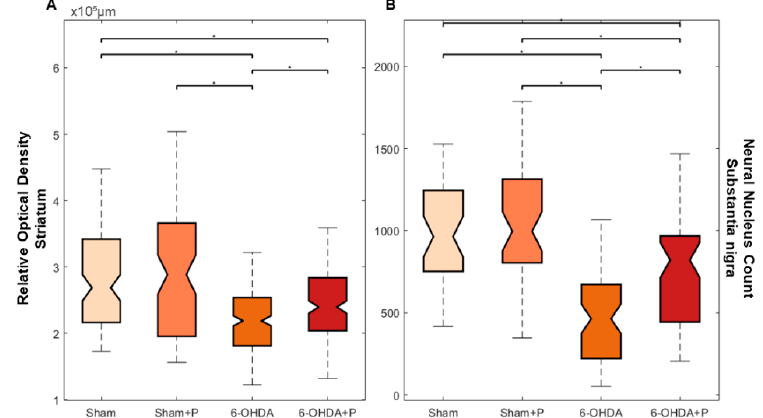
Figure 9. Statistical analysis of the TH immunohistochemistry. ( A ) Optical density of the TH-positive fibers in the striatum; median and confidence interval were as follows: 2.4949 × 10 +5 ± 0.214 × 10